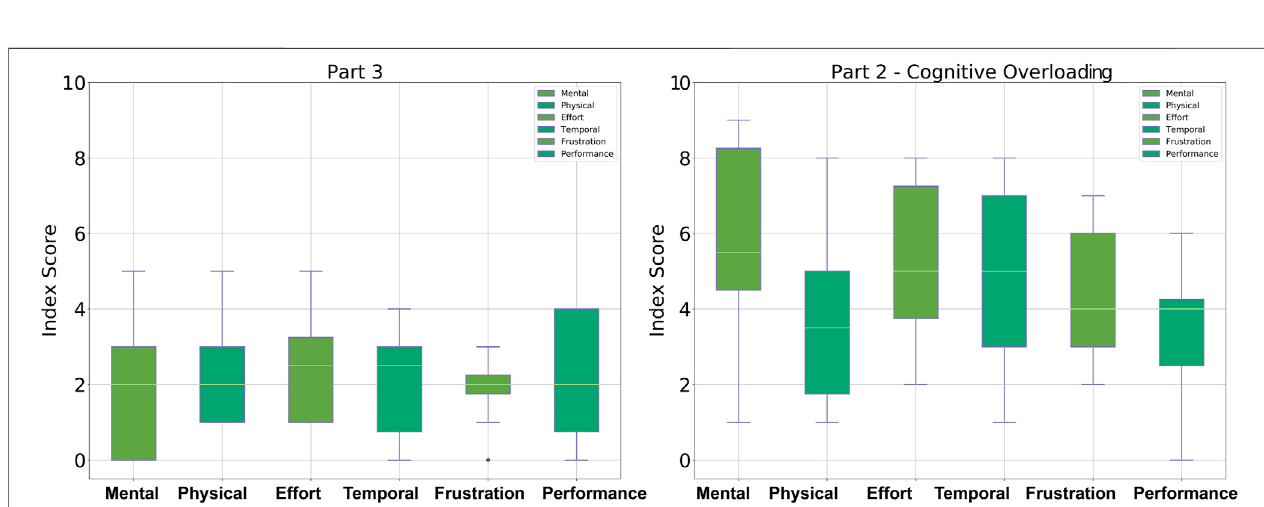
FIGURE8 | Box-plots showing the NASA TLXdata collectionfrom participants. (Panel A) shows the workload in Part Three compared to (Panel B) which shows the workload from participants during from Part Two.